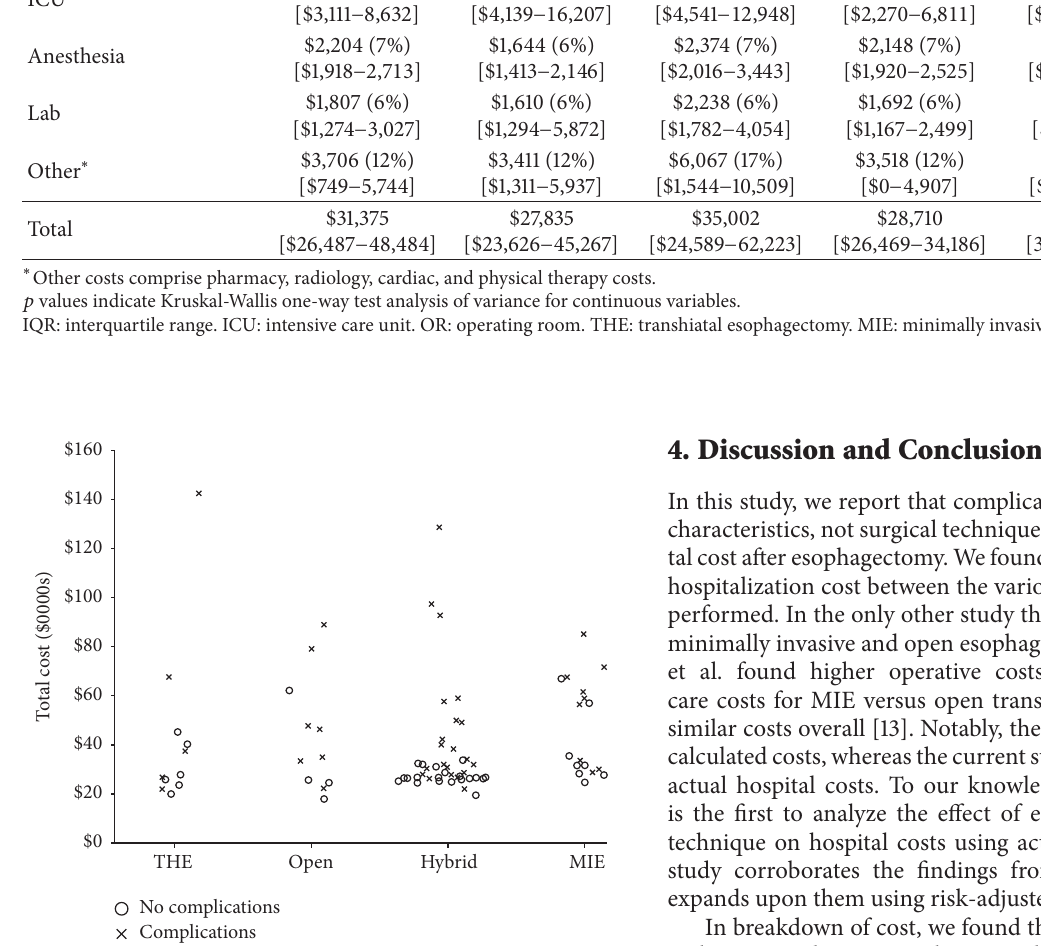
Figure 1: Range of cost for each procedure and by presence of postoperativecomplications.THE:transhiatalesophagectomy.MIE: minimally invasive